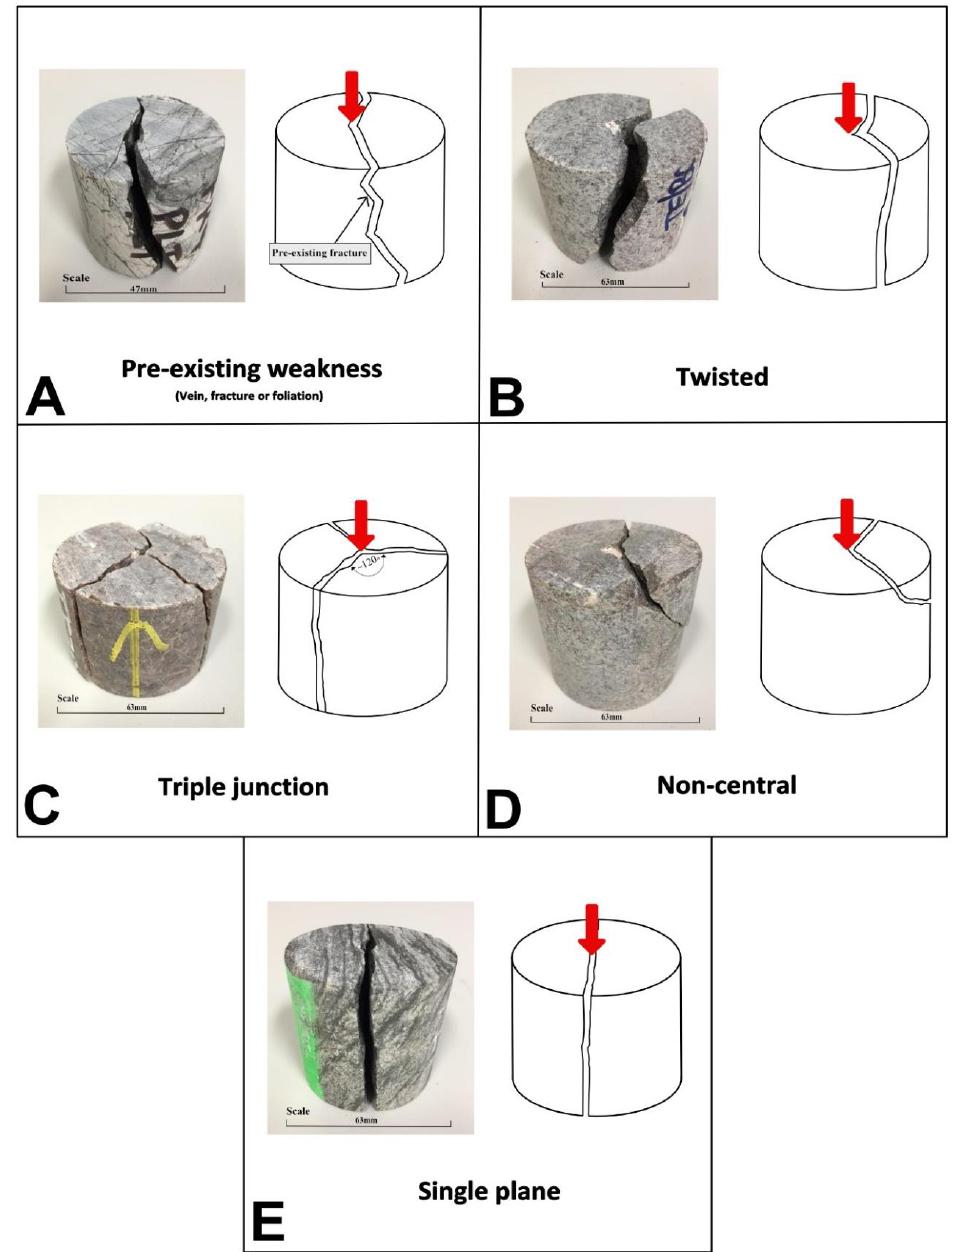
Figure 4. Photographs and schematic drawings showing the failure modes observed during the point load tests. Red arrows indicate the direction of the maximum principal stress. ( A ) Example of failure along a pre-existing weakness (here, a vein); sample TE/FR4. ( B ) Example of twisted failure mode; sample TE/BO8. ( C ) Example of failure by triple junction; sample TE3B. ( D ) Example of non-central failure; sample TE3C. ( E ) Example of failure along a single plane; sample TE1D.